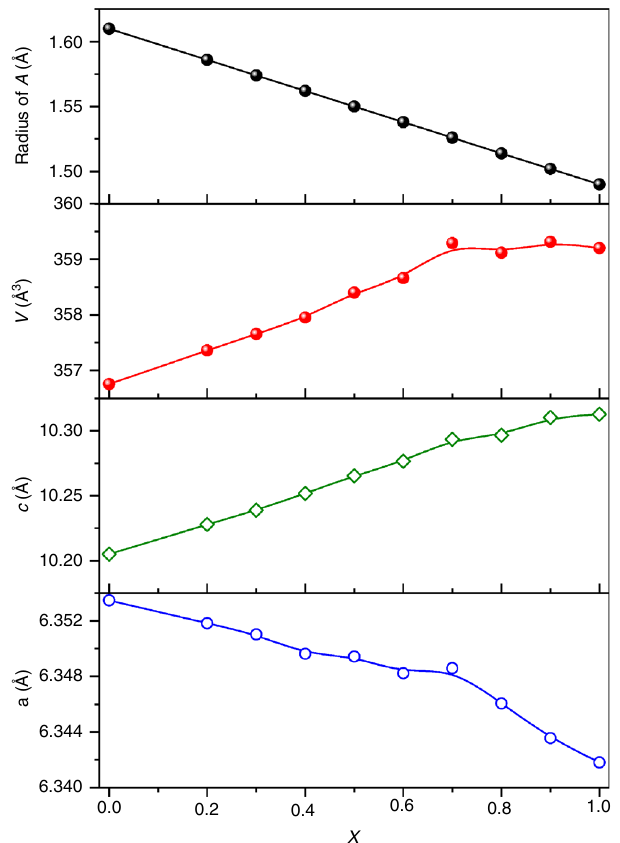
Fig. 1 Lattice parameters. Plots of the average A-site size and re fi ned lattice parameters for CaBa 1 − x Pb x Zn 2 Ga 2 O 7 along with the increasing Pb content. The average radius of A -site cation is calculated according to the equation: r (A 2 + ) = (1 − x ) r (Ba 2 + ) + x r (Pb 2 + ). Source data are provided as a Source Data fi